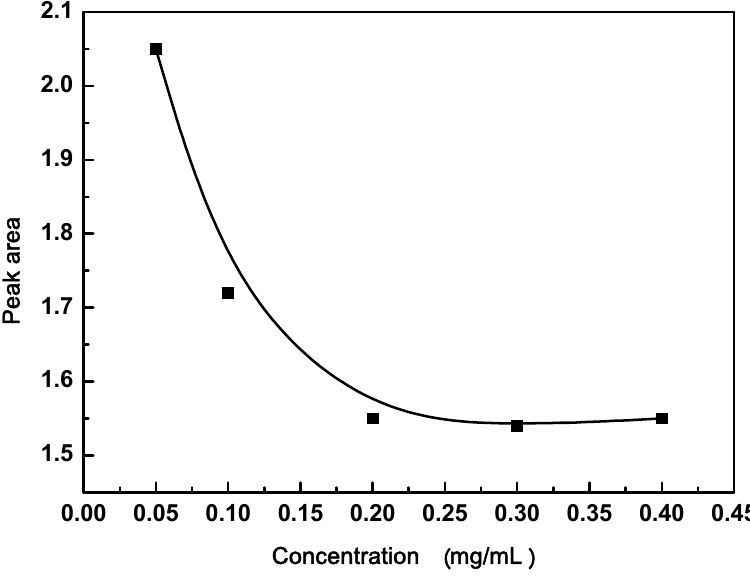
Figure 4. The influence of GO concentration on the adsorption of tyrosine (Tyr) amino acid.